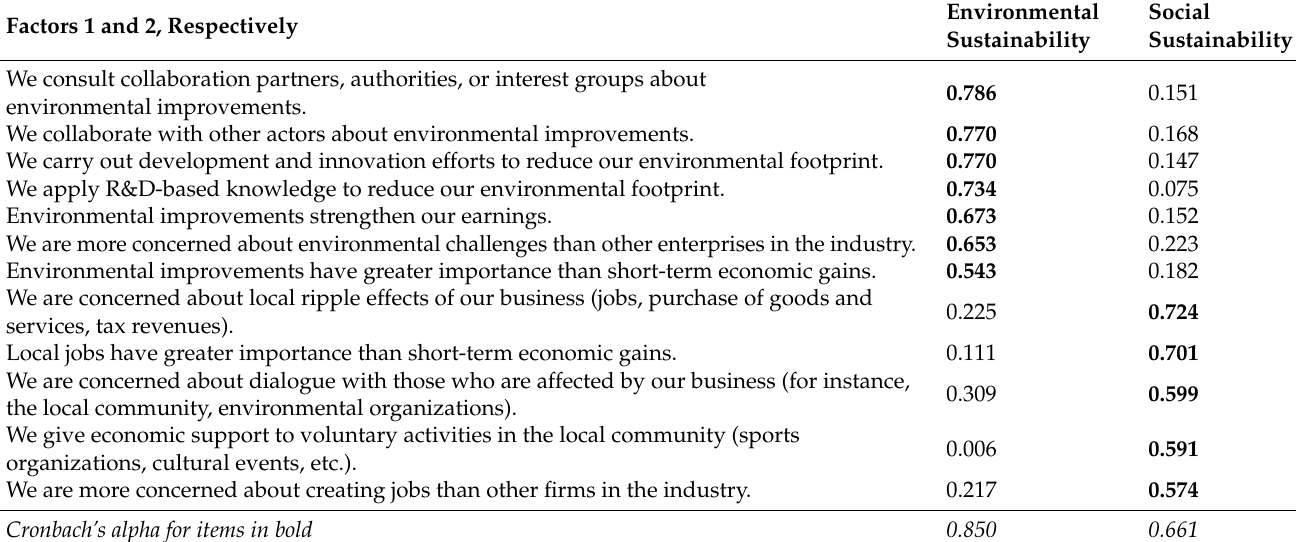
Table 1. Principal component factor analysis using orthogonal varimax rotation. N =